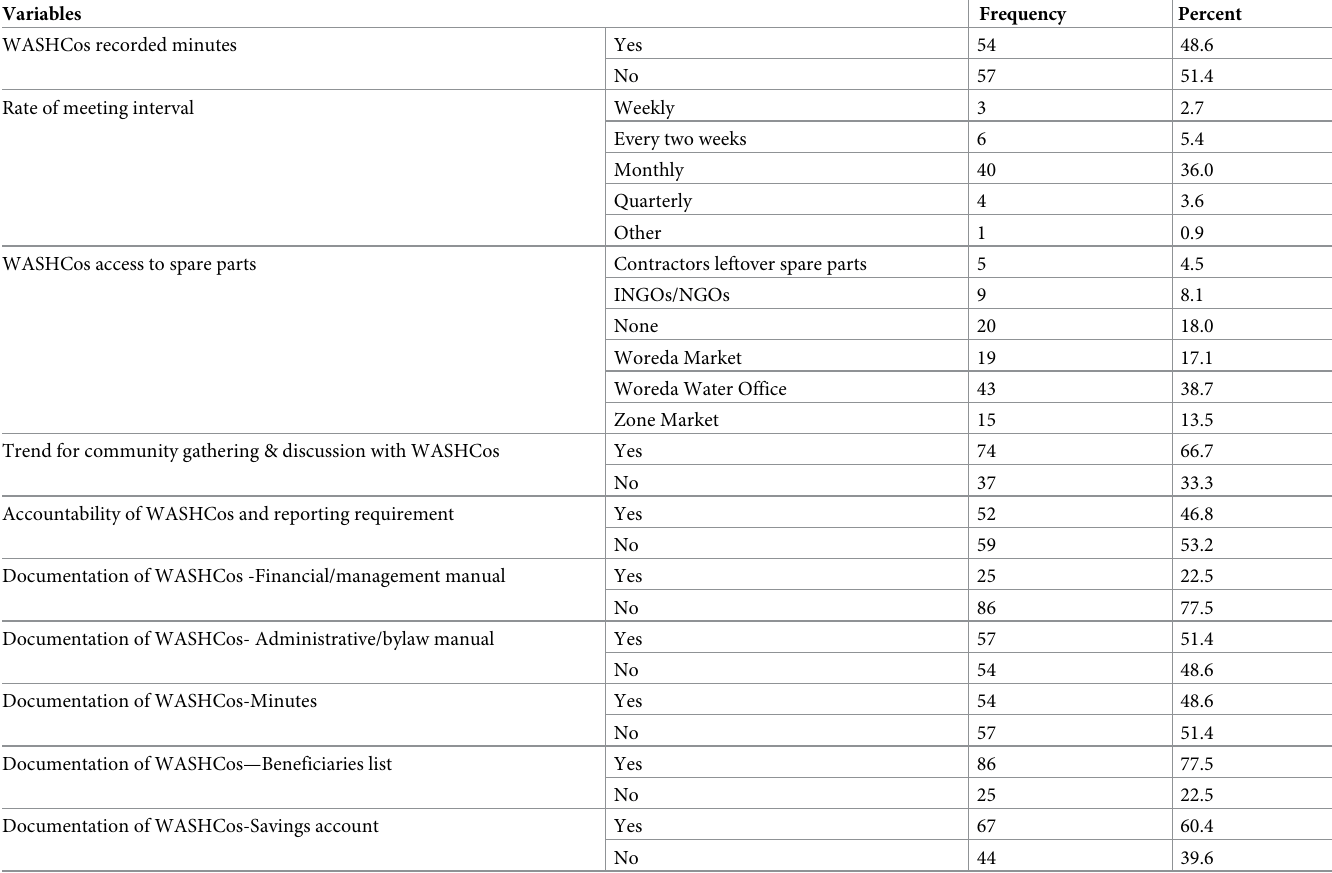
Table 8. Results of institutional related factors for basic water functionality in Afar and Amhara regions of